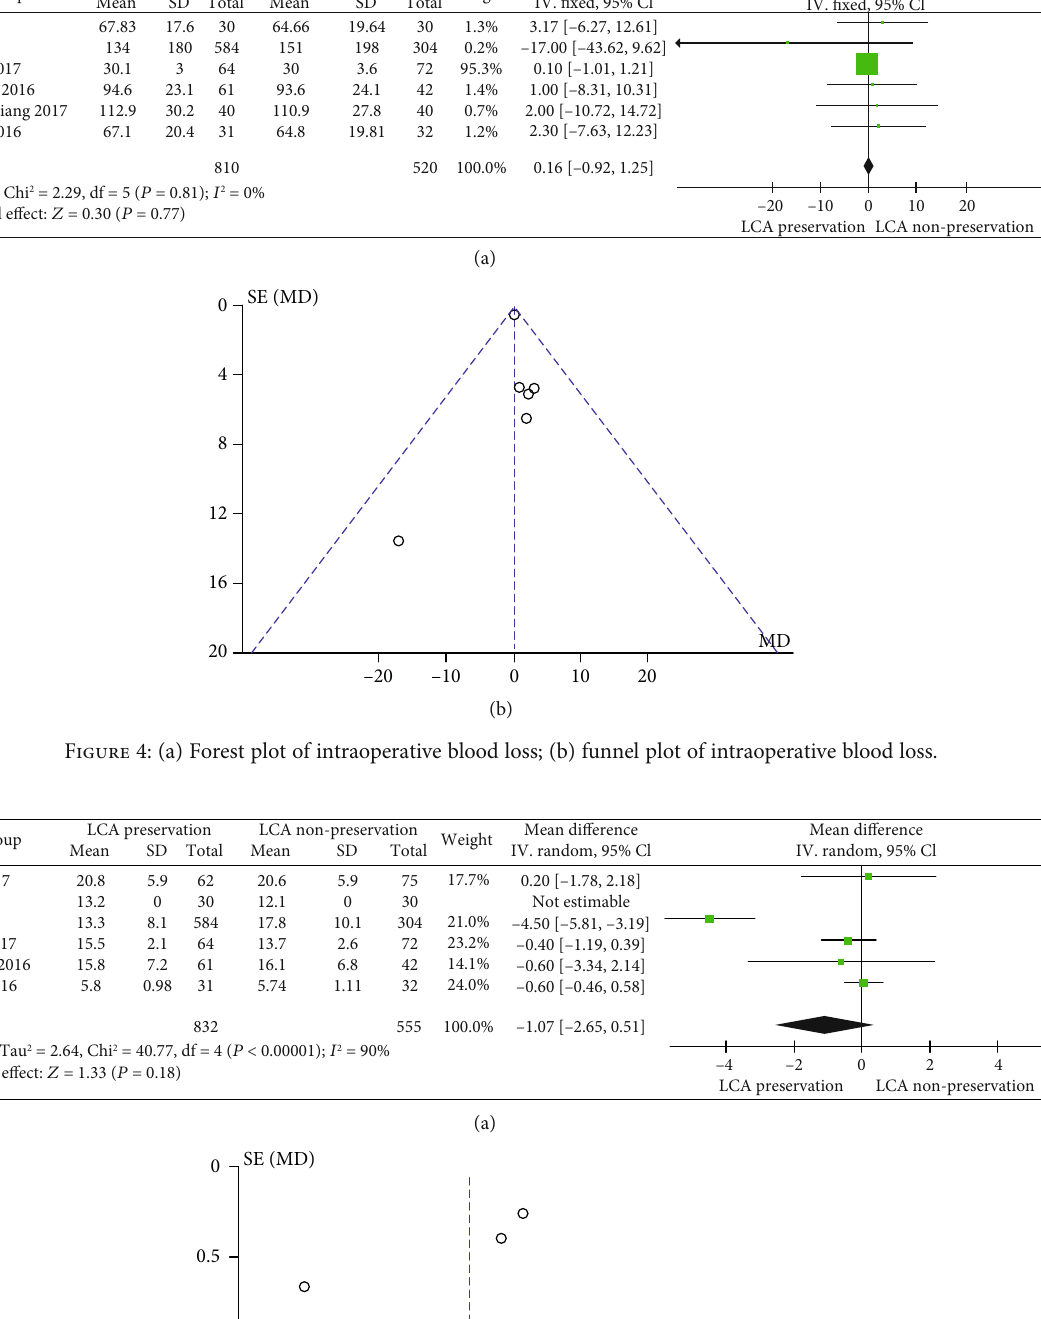
0.77)Total Heterogeneity: Chi 2 = 2.29, df = 5 ( P = 0.81); I 2 = 0% Test for overall effect: Z = 0.30 ( P =